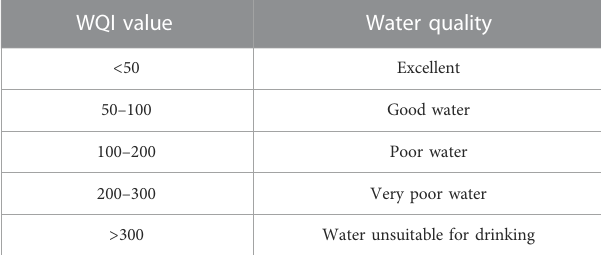
TABLE 2 Groundwater classi fi cation using the water quality